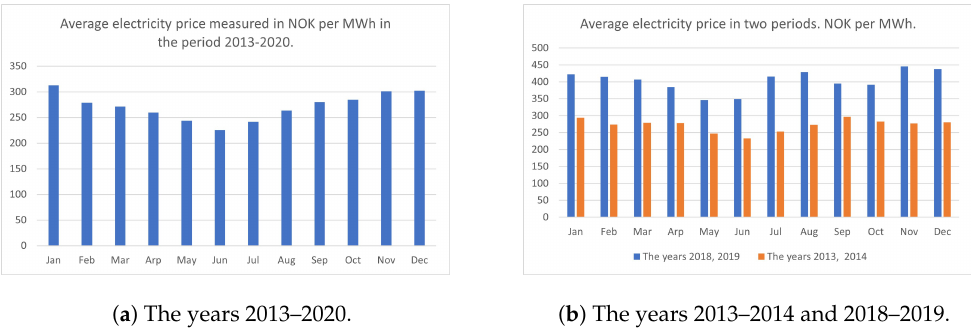
Figure 6. Average electricity price in the period of 2013–2020 and in the periods 2018–2019 and 2013–2014. NOK per MWh. Table 7. Average monthly prices measured in NOK per MWh in the Nordic electricity market for